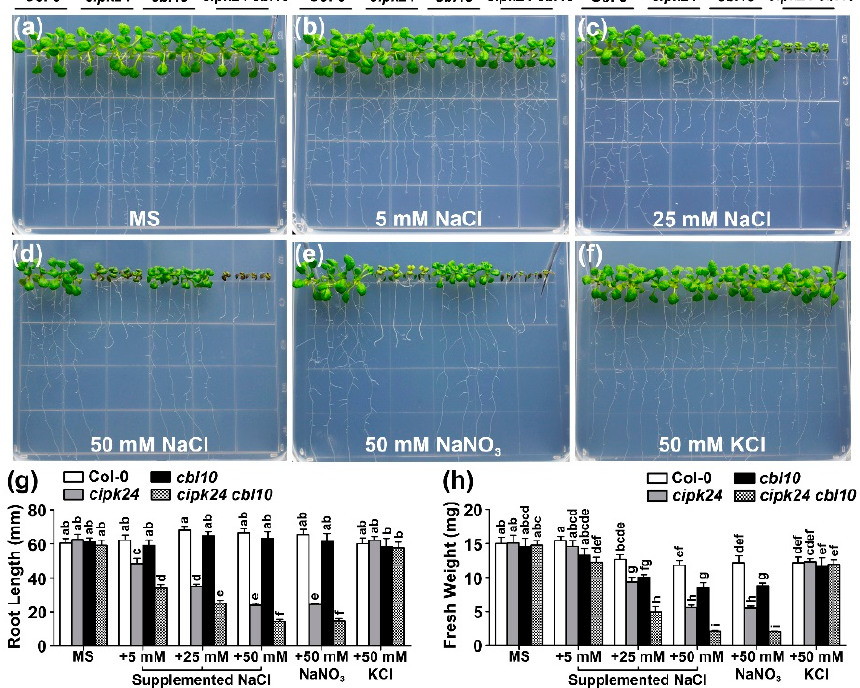
Figure 3. The cipk24 cbl10 double mutant plants are more sensitive to external Na + than the cipk24 and cbl10 single mutants. ( a–f ) Growth phenotype of Col-0, cipk24 , cbl10 and cipk24 cbl10 under different concentrations of external salt. Five-day-old wild type and mutant seedlings were transferred onto the MS medium or MS supplemented with 5 mM, 25 mM and 50 mM NaCl or 50 mM NaNO 3 or 50 mM KCl. Photgraphs were taken on the 14th day after the transfer; ( g ) length of primary roots and ( h ) fresh weight of seedlings on the 14th day after the transfer. Data are presented as the mean ± SE of triplicate experiments. Values labeled with different letters are significantly different ( p < 0.05).